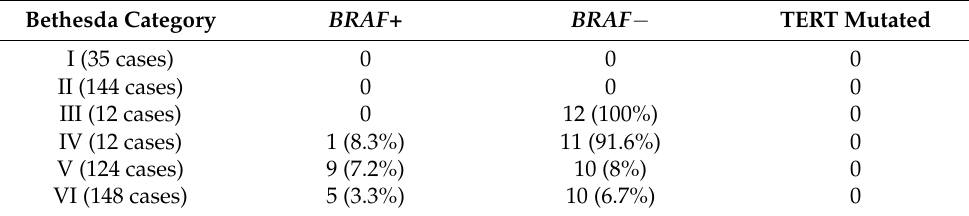
Table 9. Molecular testing for BRAF V600E and TERT promoter mutations in the subcentimeter series. Bethesda